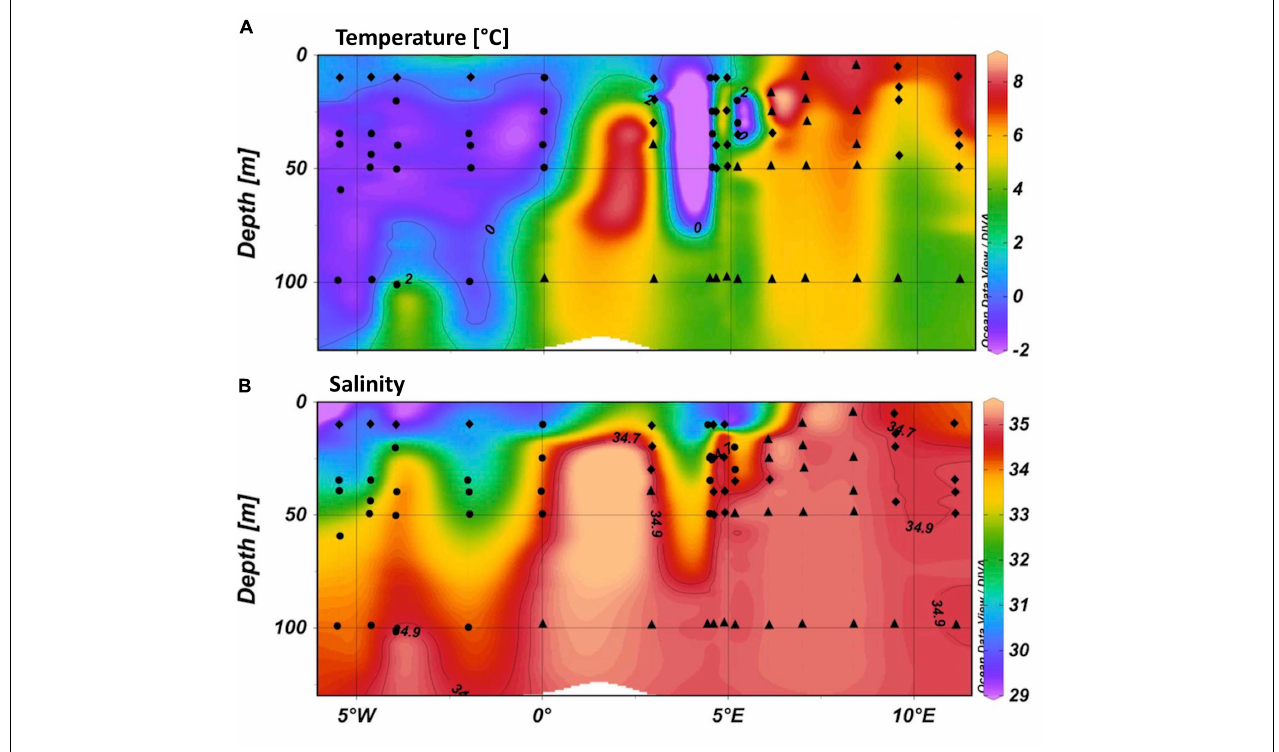
FIGURE 2 | Temperature (A) and salinity (B) plotted along the cruise track using 1 m averaged CTD data. Water masses were identified after Cokelet et al. (2008). Circles identify Polar Water (PW), diamonds identify Mixed Water (MW), and triangles identify Atlantic Water (AW).